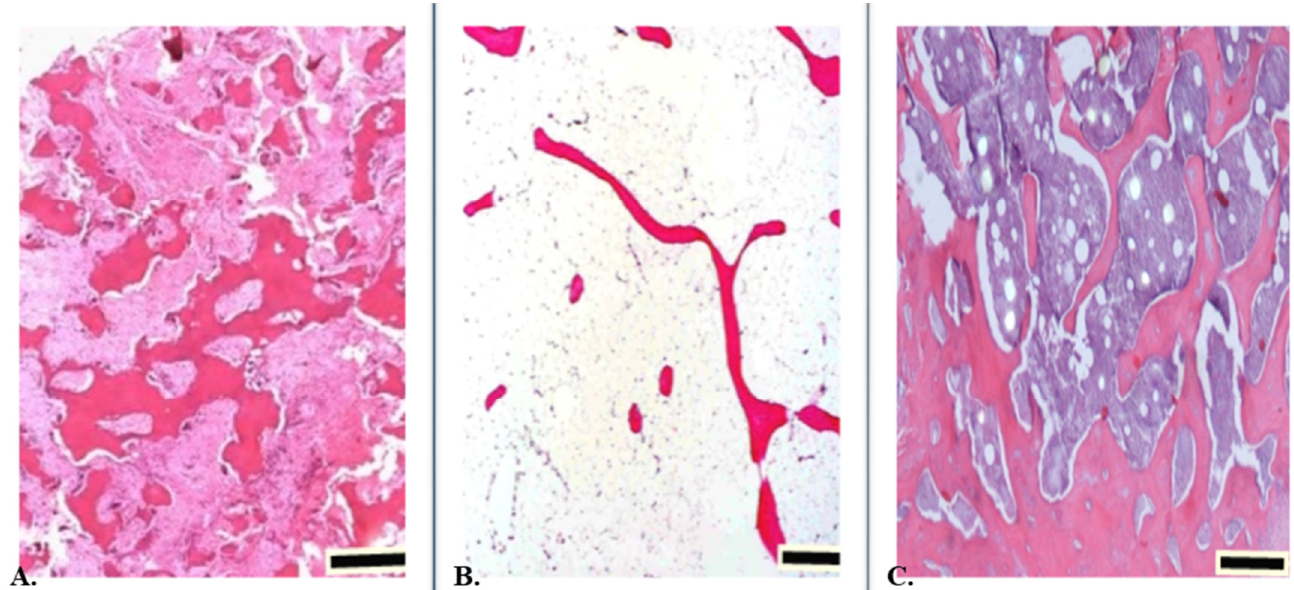
Figure 3. Histological structure of altered bone tissue. ( A ) Paget’s disease is a bone disorder. Histologically, the bone appears mosaic in appearance. It has thick cement lines that demarcate the disorderly lamellar bone. Such extensive trabeculae and lack of organization of the cortex are the cause of the loss of resistance to strain and therefore greatly increase the susceptibility to fracture. H & E section; scale bar: 200 µm. ( B ) In osteoporotic bone, there is an increased amount of adipose tissue appearing in the intertrabecular area. Therefore, for the same volume, the bone has much less density but is more frangible. Increased medial adiposity, associated with intratrabecular connectivity, emphasizes the functional connection between bone and marrow. Thin trabeculae are separated from each other. H & E section; scale bar: 100 µm. ( C) Longitudinal section of the cancellous bone of the obese rat. Visible network of trabeculae separated by intercellular spaces containing islands and clusters of haematopoietic cells admixed with adipocytes. H & E section; scale bar: 500 µm.